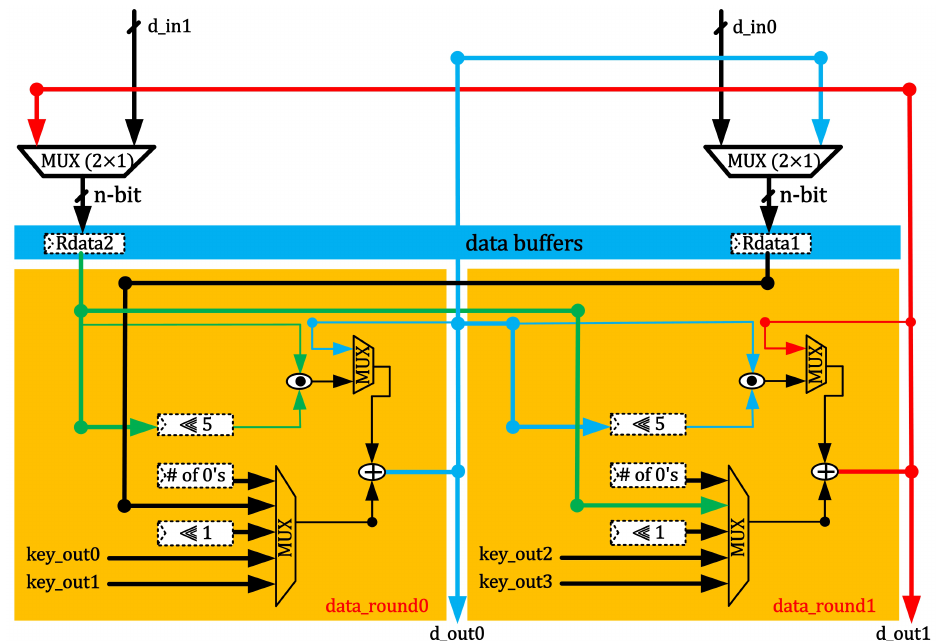
Figure 2. Proposed data expansion architecture for SIMECK32/64.